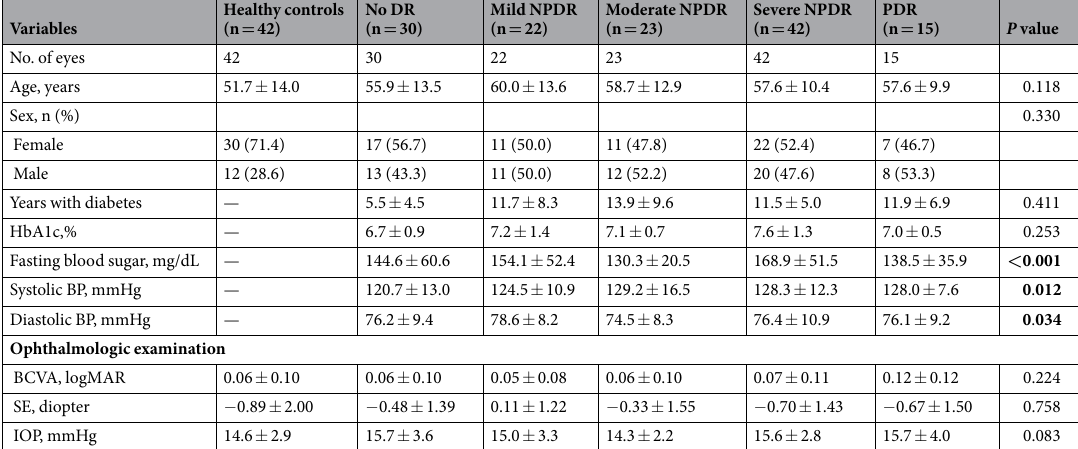
Table 1. Demographic and clinical characteristics of the eyes (n = 174) according to the study group Data are expressed as mean ± standard deviation (95% confidence interval). Statistical tests: an analysis of variance (ANOVA) (continuous data); the Cochran-Armitage test (categorical data, e.g. sex) for trends; the Kruskal- Wallis test for visual acuity. Factors with statistical significance are shown in bold. BCVA, best-corrected visual acuity; BP, blood pressure; DR, diabetic retinopathy; IOP, intraocular pressure; logMAR, logarithm of the minimum angle of resolution; NPDR, non-proliferative diabetic retinopathy; PDR, proliferative diabetic retinopathy; SE, spherical